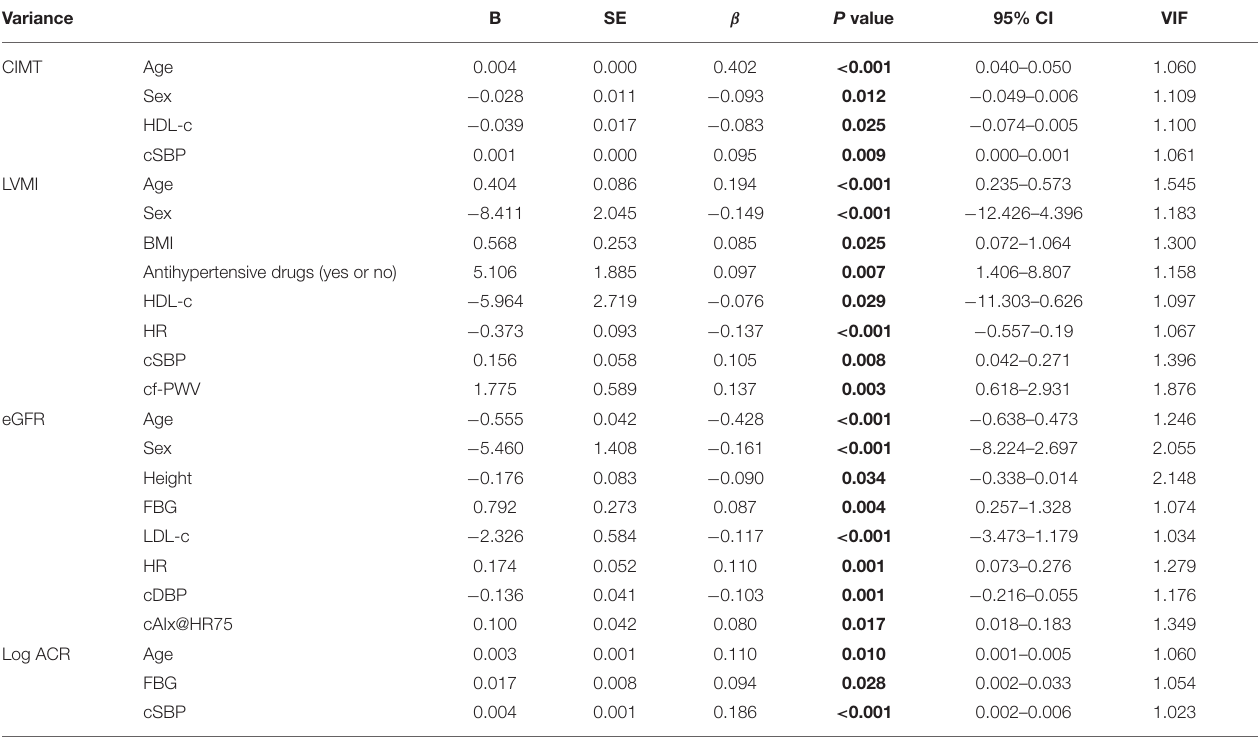
TABLE 2 | Multiple stepwise linear regression of risk factors of target organ damage in the overall studied population. Variance